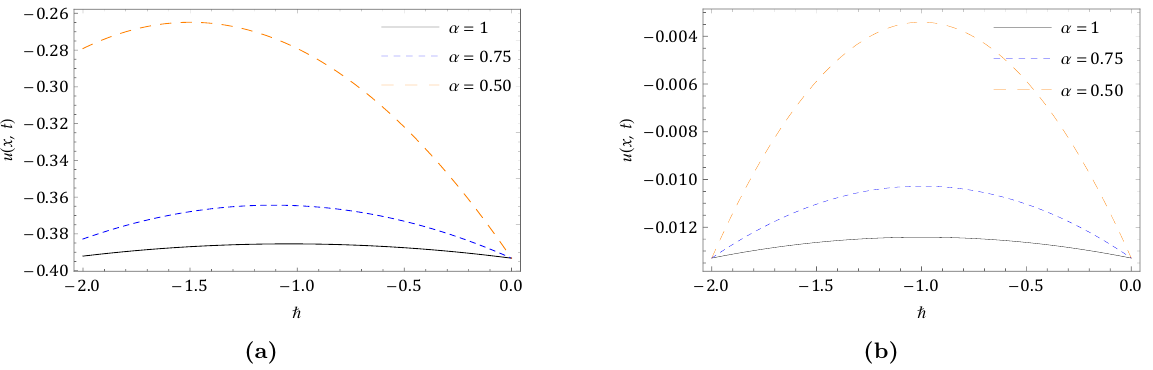
Figure 7. Nature of water elevation with b ( x ) at n = 1 , (cid:125) = − 1 , β = 8 and α = 1.